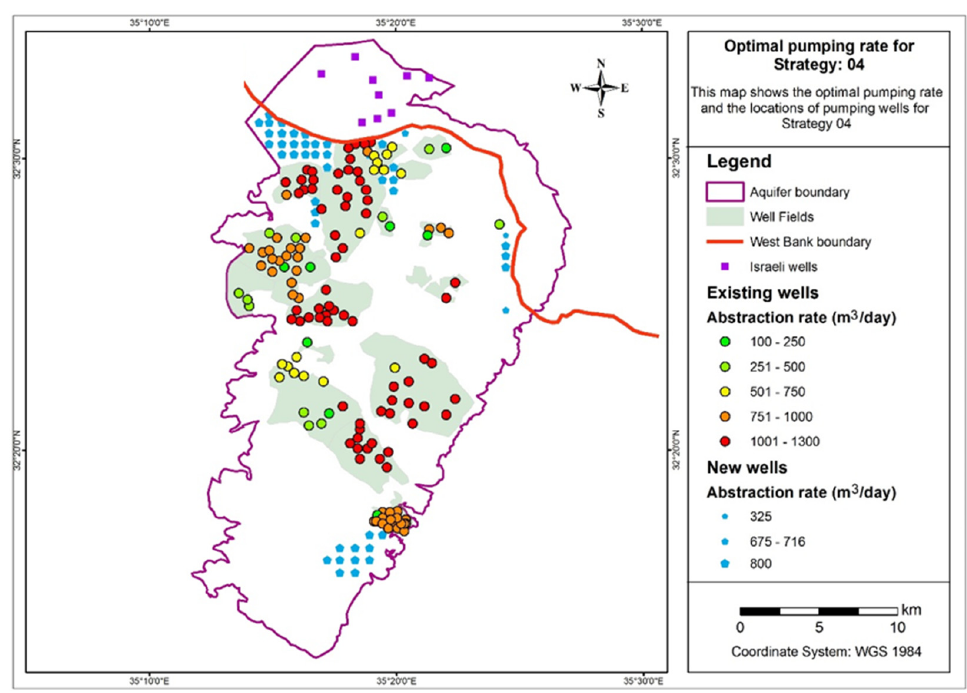
Figure 22. Wells distribution and water balance results for Strategy 03.